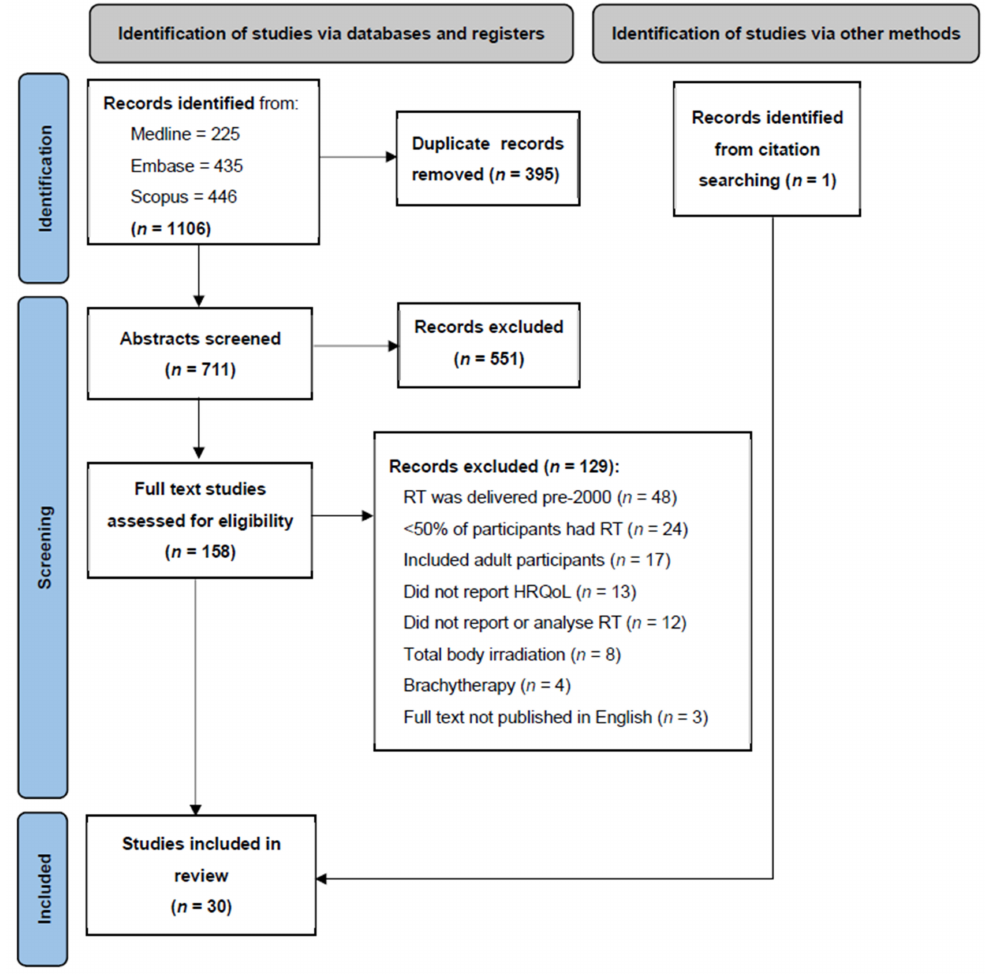
Figure 1. Preferred reporting items for systematic reviews and meta-analyses (PRISMA) flow diagram detailing selection process and exclusion reasons. Abbreviations: RT, radiation therapy; HRQoL, health-related quality of